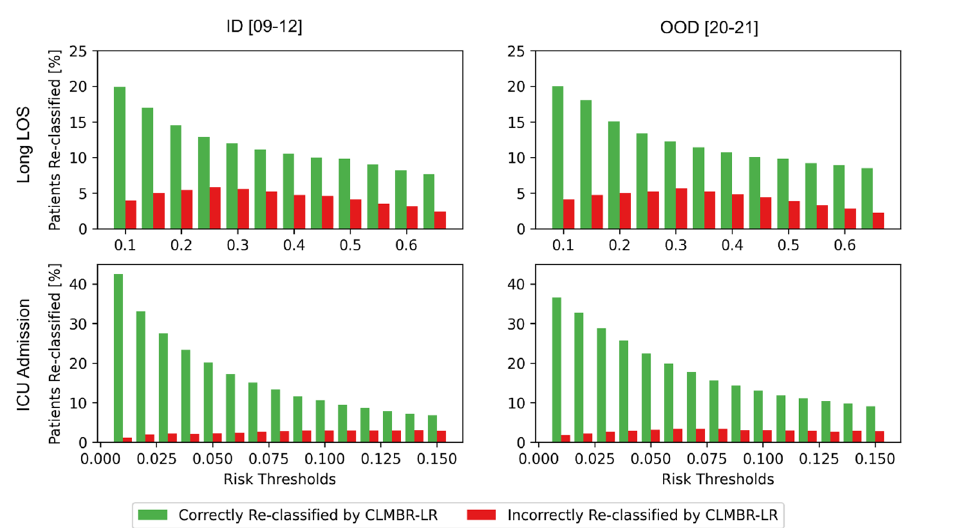
Figure 6. The proportion of patients correctly and incorrectly re-classified by CLMBR-LR. Green bars indicate the proportion of patients that were incorrectly classified by count-LR but were correctly re-classified by CLMBR-LR. Red bars indicate the proportion of patients that were correctly classified by count-LR but were incorrectly re-classified by CLMBR-LR. Together, these represent the percentage of decisions that would have been affected if CLMBR-LR were used instead of count-LR. LR logistic regression; CLMBR clinical language model-based representations; LOS length of stay; ICU intensive care